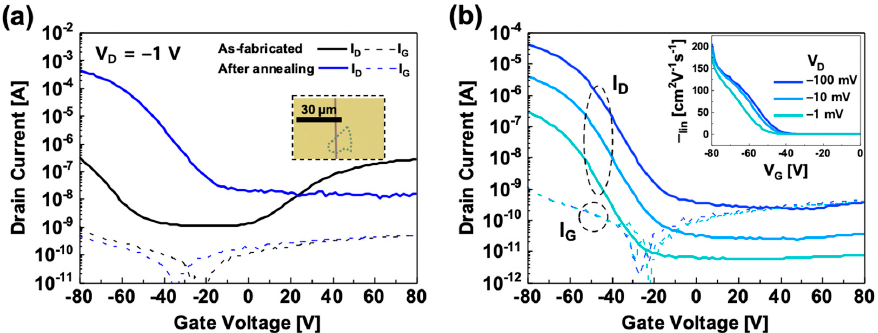
Figure 2. ( a ) Transfer characteristic curves of the WSe 2 p-type metal-oxide-semiconductor (PMOS) before (as-fabricated) and after the post-annealing process at V D of − 1 V (W / L = 10); ( b ) Transfer characteristic curves and linear mobility plot (inset) of the post-annealed WSe 2 PMOS at V D of − 1 mV, − 10 mV, and − 100 mV.